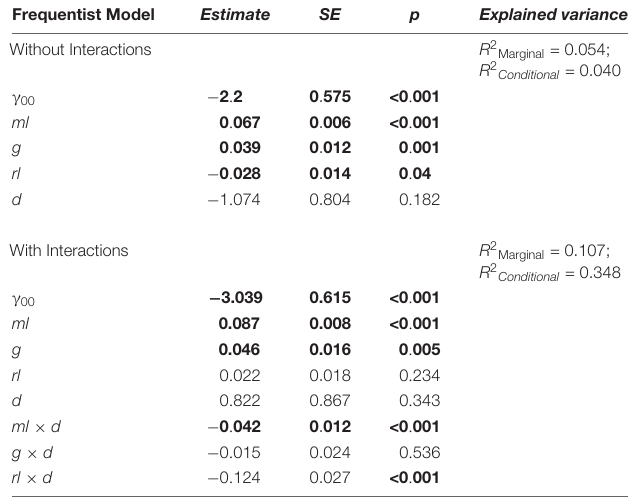
TABLE 4 | Predictiveness of different factors (i.e., ml , g , rl , and d ) regarding the criterion cogIll in two different frequentist models (with and without interactions). Frequentist Model